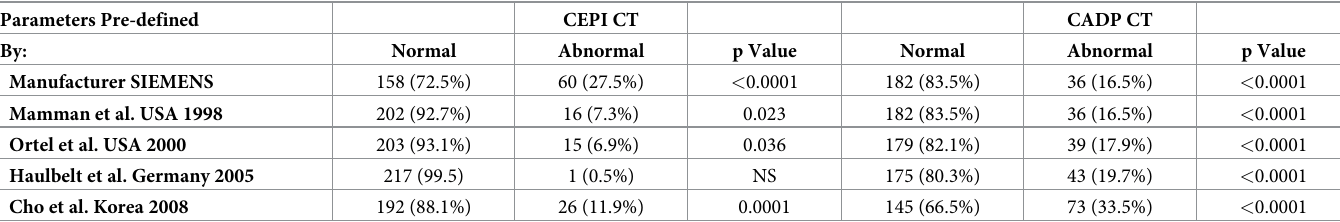
Table 5. Comparison of the local reference values of the CT EPI and CT CADP with those predefined by the manufacturer and other foreign